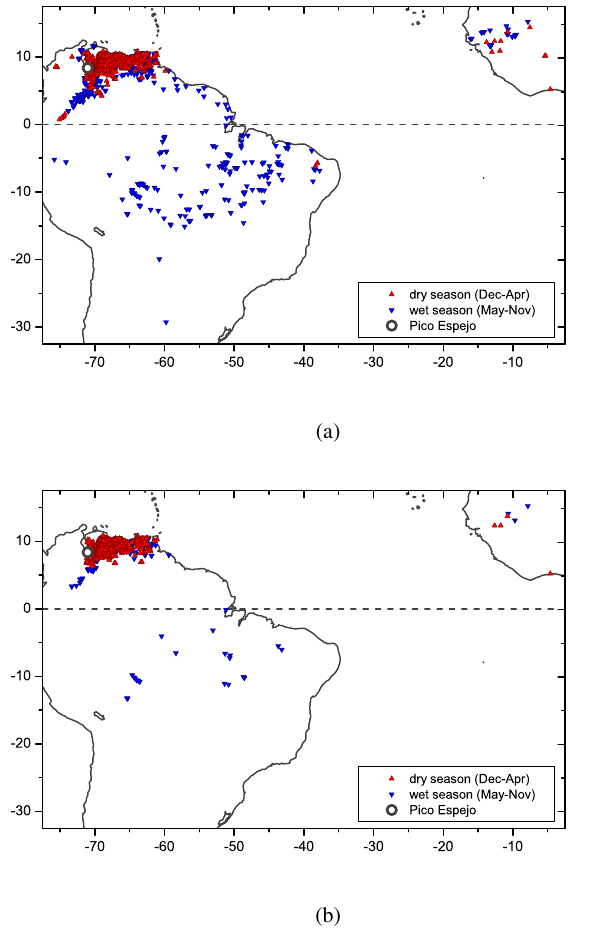
Fig. 5. Possible fire events affecting the observations according to the trajectory analysis ( − 10 days). Red triangles represent the Venezuelan dry season, blue triangles its wet season. Panel (a) shows all possible fire events not accounting for precipitation along the air mass transport path way. Panel (b) shows all fire events ex- cluding events with precipitation along the transport path way. Fig. 4. Diurnal cycles of relative humidity RH (%), ambient par- ticle volume concentration V (D p = 10–470nm) (µm 3 cm − 3 ), am- bient aerosol number concentration N (cm − 3 ), refractory particle number concentration N 300 ◦ C (cm − 3 ), and absorption coefficient b abs (Mm − 1 ). The bars indicate 25th percentile–median–75th per- centile, the squares the arithmetic mean. Red colour indicates ob- servations during the dry season, blue colour during the wet season. The time is local time (UTC-4.5h).